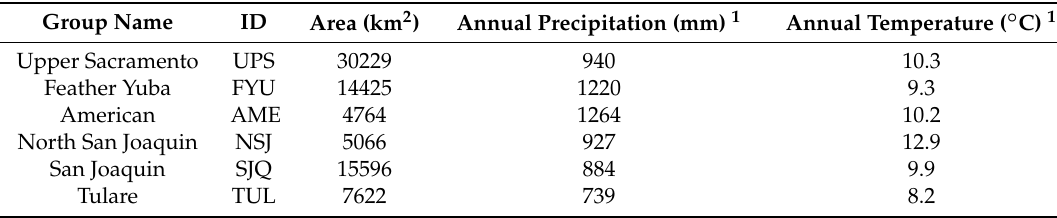
Table 1. General information of six forecasting groups.